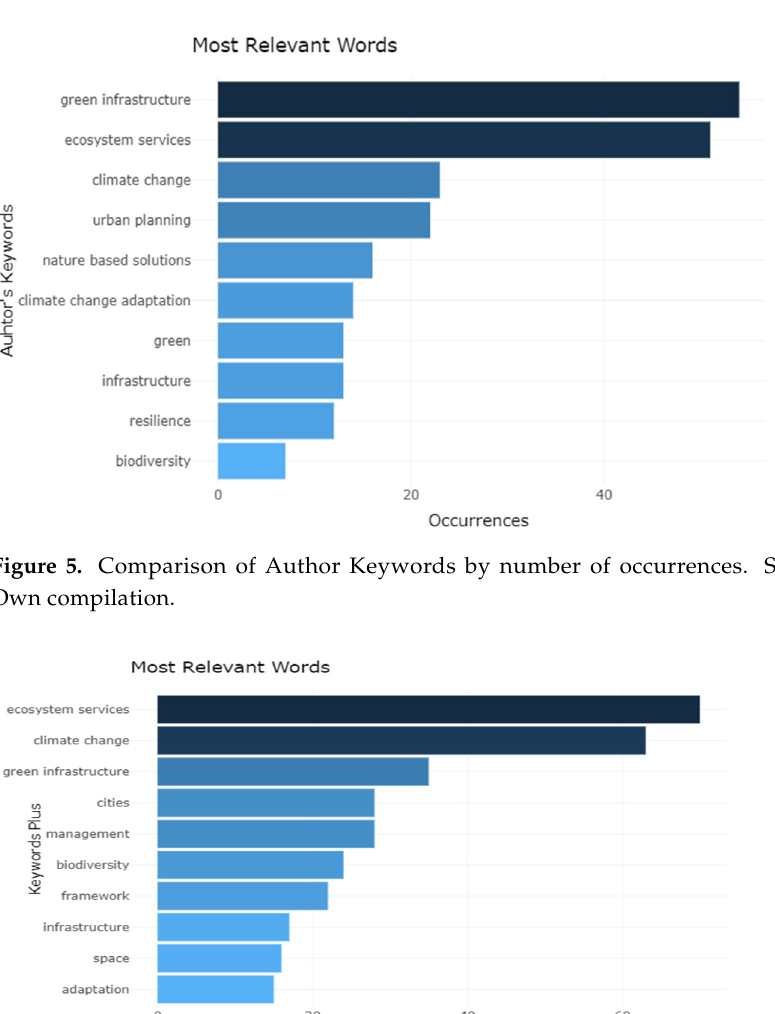
7 of 18 Figure 4. Overlay Visualization of Future Trends by all Keywords. Source: VOSviewer. Own Compilation. If we analyze the importance of words according to the two criteria (Author Key-